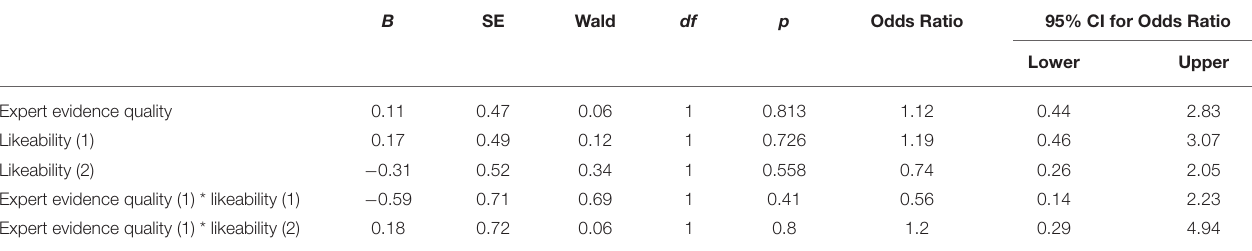
TABLE 10 | Logistic regression predicting sentencing decision from evidence quality condition, likeability condition, and their interaction. B